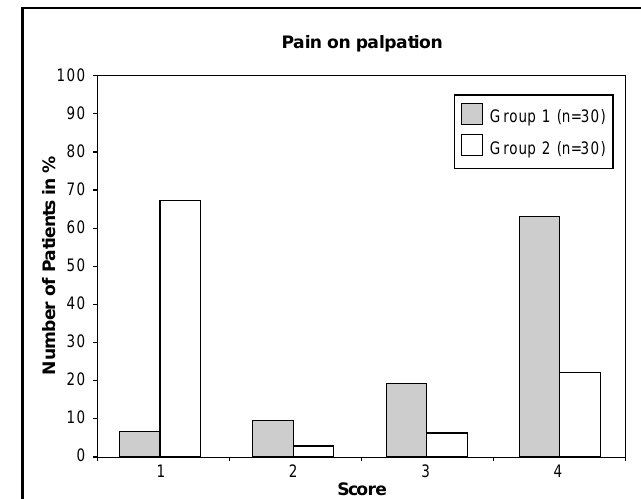
Figure 4: Distribution differences in pain on palpa- tion at the end of six weeks of treatment in the therapy